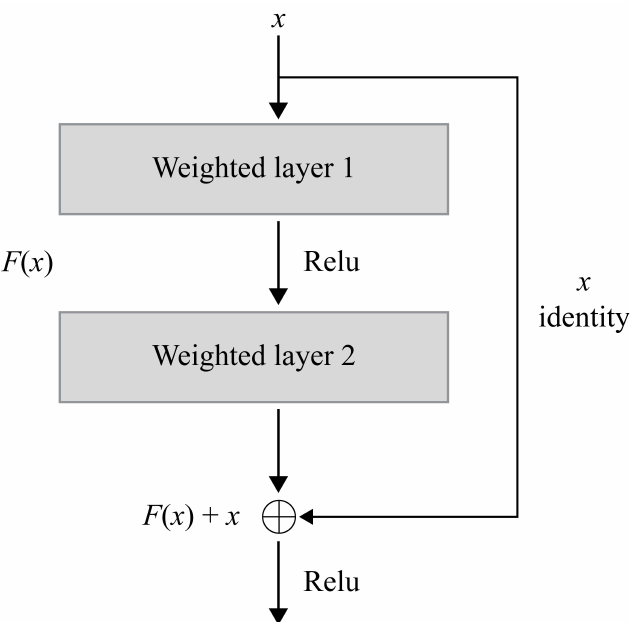
Figure 2. Bottleneck block in the ResNet